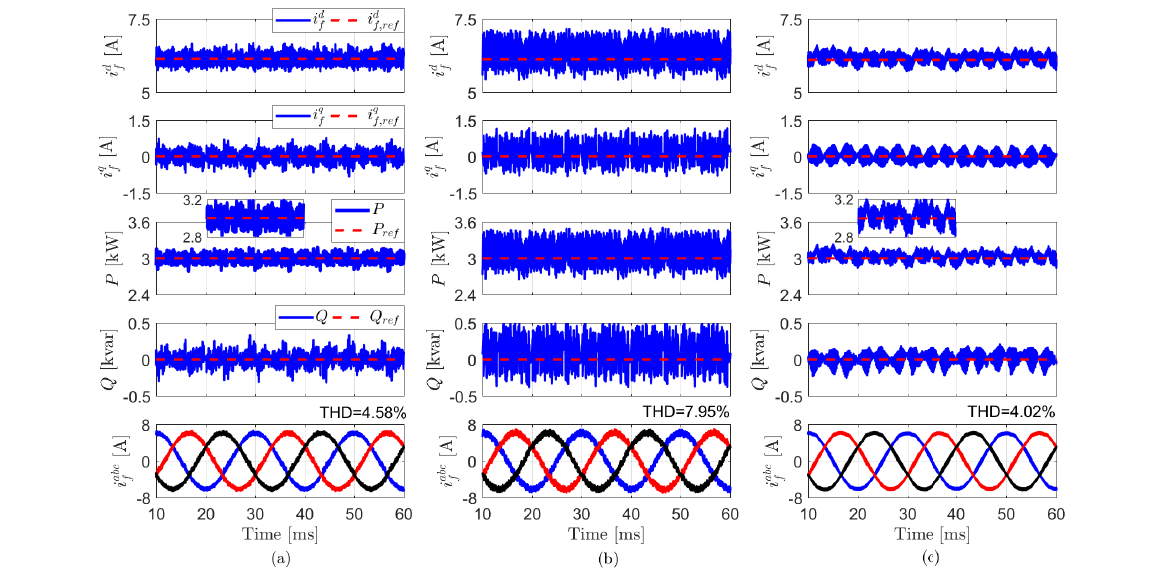
Figure 8. Steady-state performance of the different control techniques: ( a ) proposed DMPC, ( b ) traditional DMPC, and ( c )